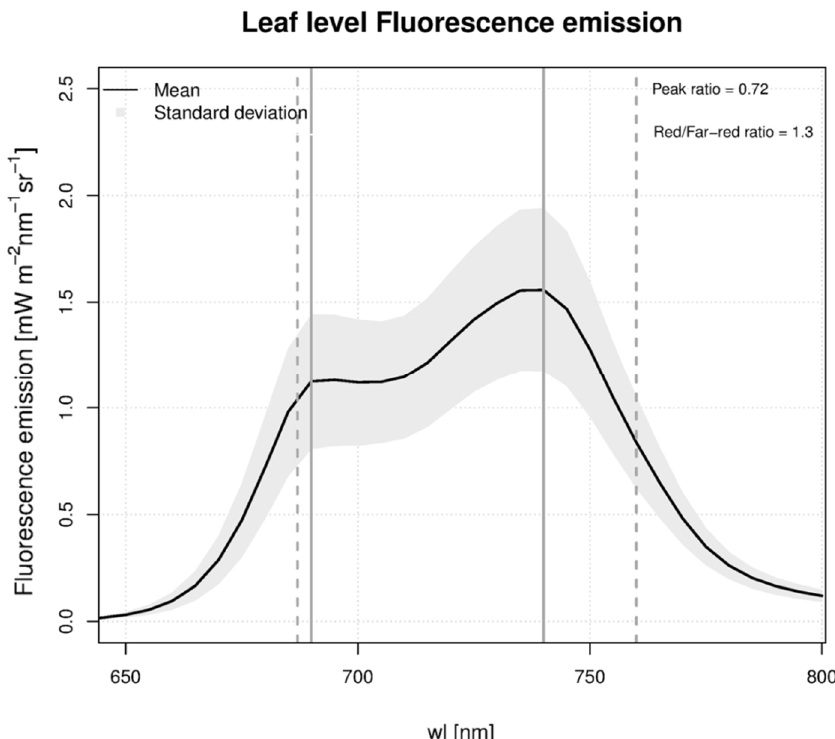
Figure 4. Grass leaf level fluorescence emissions acquired in the laboratory with the SPEX Fluorolog III spectrofluorometer using a 532 nm excitation wavelength. The red peak is expected to be partially reabsorbed at the canopy level. The ratio between fluorescence obtained at 689 nm and 760 (red/far-red ratio = 1.3) is used to qualitatively assess the SIF retrievals made at canopy level with the different instruments (see Table 2). Traditionally, the red/far-red ratio is computed with the values at the peaks (690 nm, 740 nm), which would provide a far-red = 0.72. The two solid vertical lines denote the peaks of the red and far-red fluorescence, whereas the dotted lines refer to the wavelengths used for the SIF estimation.